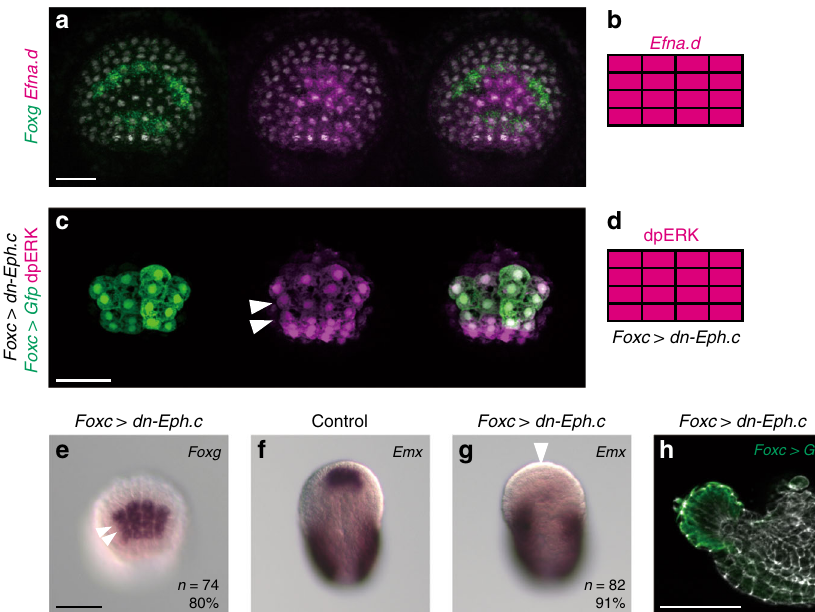
Fig. 8 Efna.d is responsible for restricting Foxg expression in the ANB. a Double in situ hybridization of Efna.d (magenta) and Foxg (green). b Depiction for Efna.d expression in the ANB. c Immunostaining of dpERK (magenta) in an embryo in which ANB cells were marked with Foxc > Gfp . The middle rows show ectopic signals for dpERK (arrowheads). d Depiction of ANB cells stained with the anti-dpERK antibody in neurula embryos introduced with Foxc > dn-Eph.c . e – g In situ hybridization of e Foxg and f , g Emx in e , g neurula embryos introduced with Foxc > dn-Eph.c and f an unperturbed neurula embryo. In ( e ), the middle two rows of cells expressed Foxg ectopically (compared with Fig. 1b). In ( f ) and ( g ), while Emx expression in the tail was not changed, it was lost in the ANB of a Foxg morphant (arrowhead). The number of embryos examined and the proportion of embryos that each panel represents are shown within the panels. a , c , e Anterior views in which the ventral side is up. f , g Dorsal views in which the anterior is up. h Lateral view showing the morphology of a larva introduced with Foxc > dn-Eph.c . ANB cells were marked with GFP by cointroduction of the Foxc > Gfp construct and counterstained with